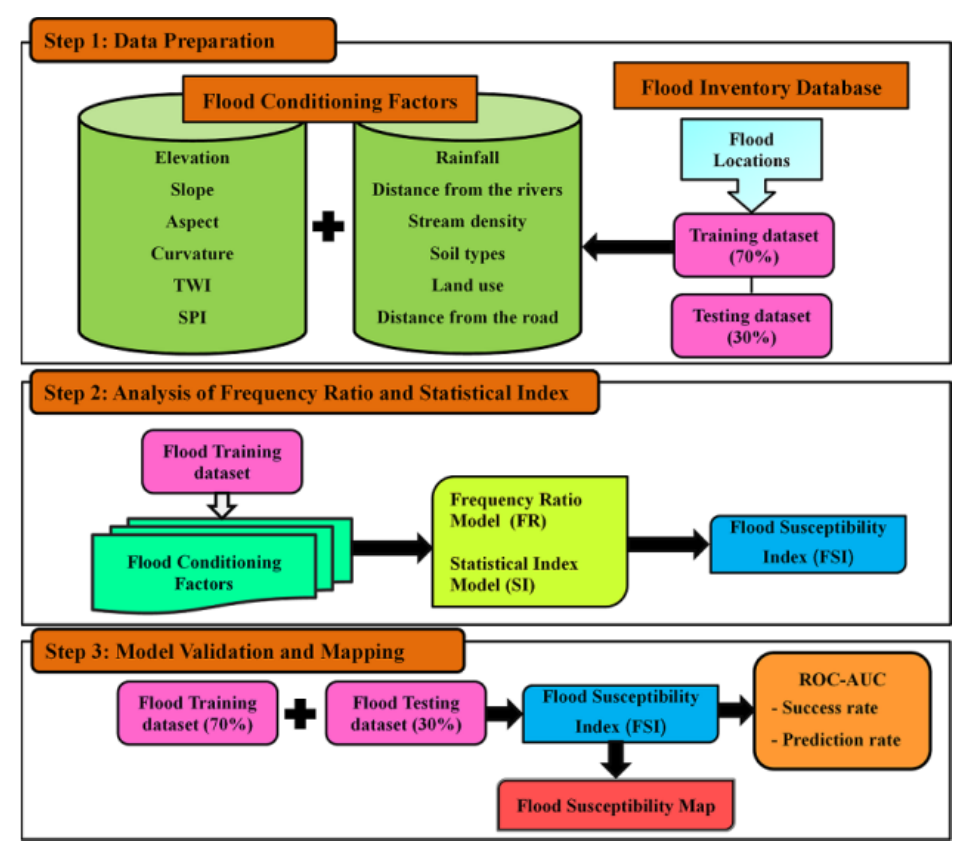
Figure 2. Flow chart of the research methodology.